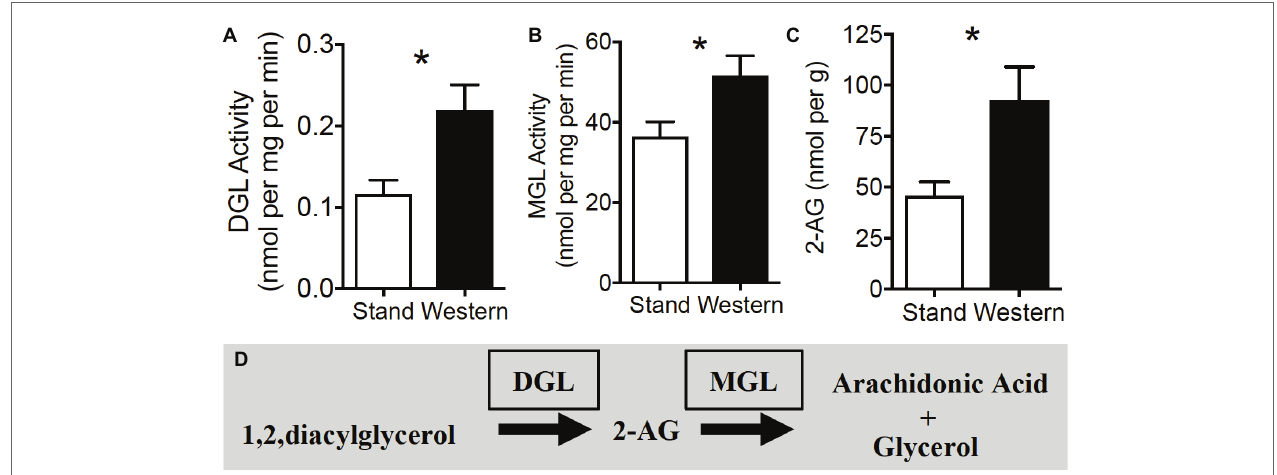
FIGURE 4 | 2-AG biosynthesis and degradation are upregulated in small intestine during obesity. Hydrolytic activity of DGL (A) and MGL (B) are increased in mice maintained on western diet (WD) when compared to controls fed a standard diet (SD). Levels of the endocannabinoid, 2-AG, are increased in jejunum mucosa of WD mice, when compared to SD mice (C) . 2-AG is formed by the hydrolysis of its 1,stearoyl,2-arachidonoyl- sn -glycerol precursor by DGL and is subsequently degraded by MGL into arachidonic acid and glycerol (D) . Data expressed as mean ± S.E.M. Analyzed using Student’s two-tailed t -test. n = 6 per condition, * p <